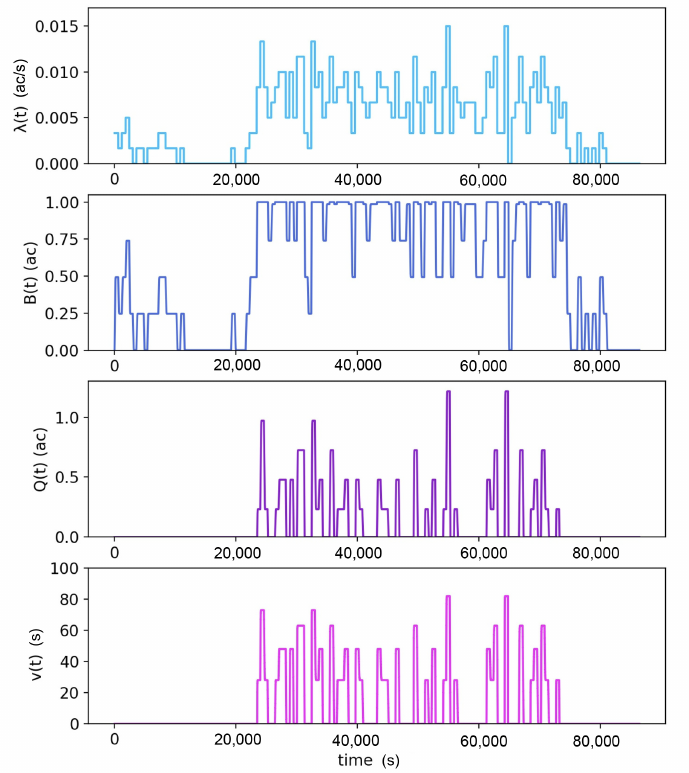
Figure 14. Time-varying states in the departure queue, λ ( t ) , B ( t ) , Q ( t ) , and v ( t ) in the i th OL period in one